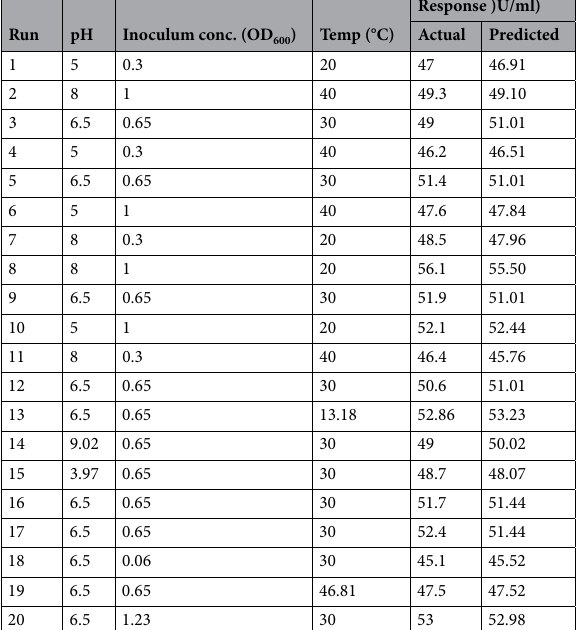
Table 4. Box–Behnken experimental design and response values for cellulolytic enzyme activity (observed and predicted